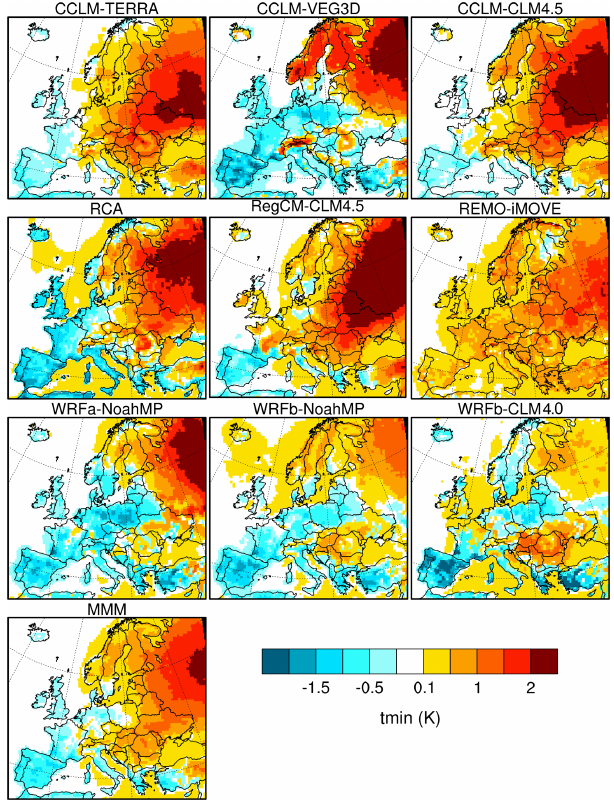
Figure 5. Seasonally averaged daily minimum 2m temperature (FOREST minus GRASS) for winter